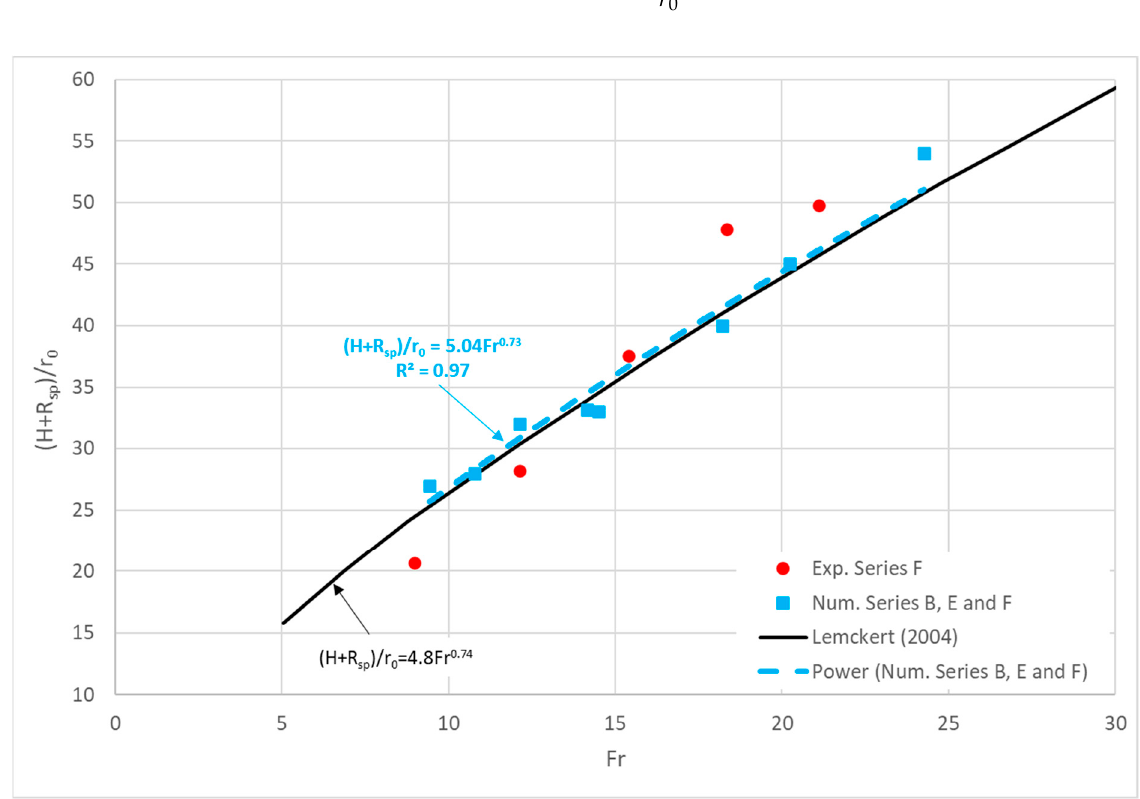
Figure 10. Lateral spread of the vertical dense discharges at the surface in the impinging flow regime [10].